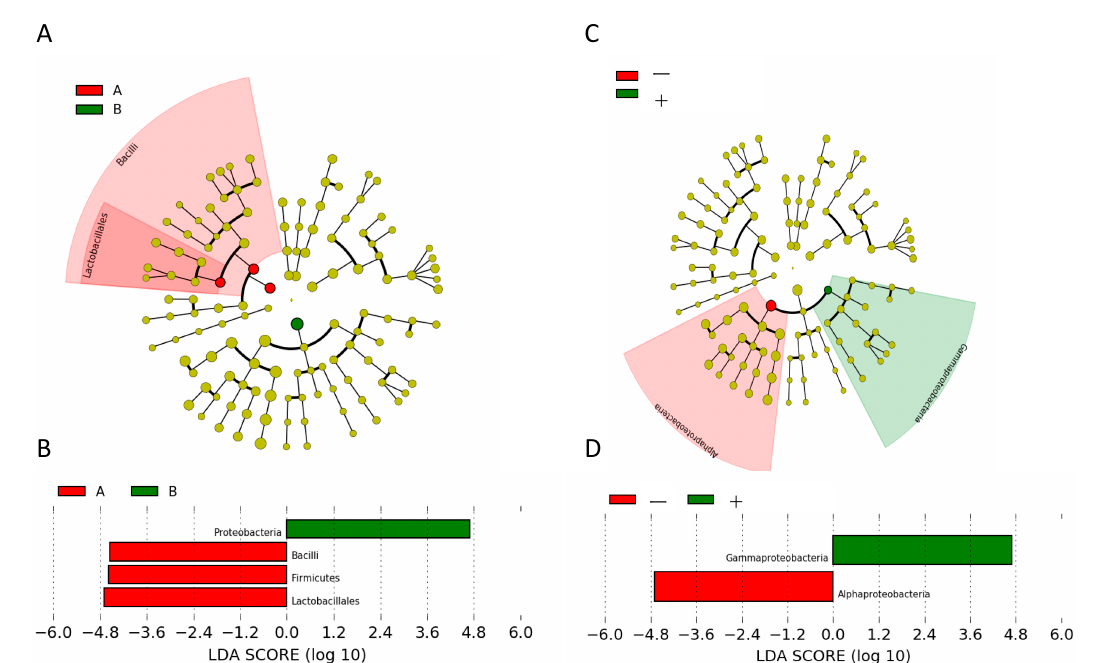
Figure 4. Differential taxa in the histology and driver mutation groups. ( A ) Cladogram of differential taxa between Types A and B histology. Dominant taxa are indicated in red for the type A group and in green for the type B group. ( B ) Kruskal– Wallis test results on the relative abundance between type A and type B histology. Type A is presented in the red column and type B in the green column. * p < 0.05. ( C ) The results of the LEfSe analysis between tumors exhibiting the presence and those exhibiting the absence of the GTF2I driver mutation. ( D ) Kruskal–Wallis test results for the relative abundance between tumors exhibiting the presence and those exhibiting the absence of the GTF2I driver mutation. * p < 0.05.